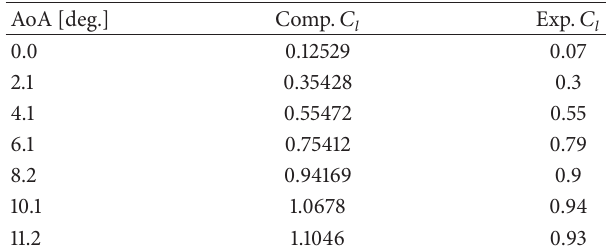
Table 2: Computed fully turbulent lift coefficients and the experi- mental lift